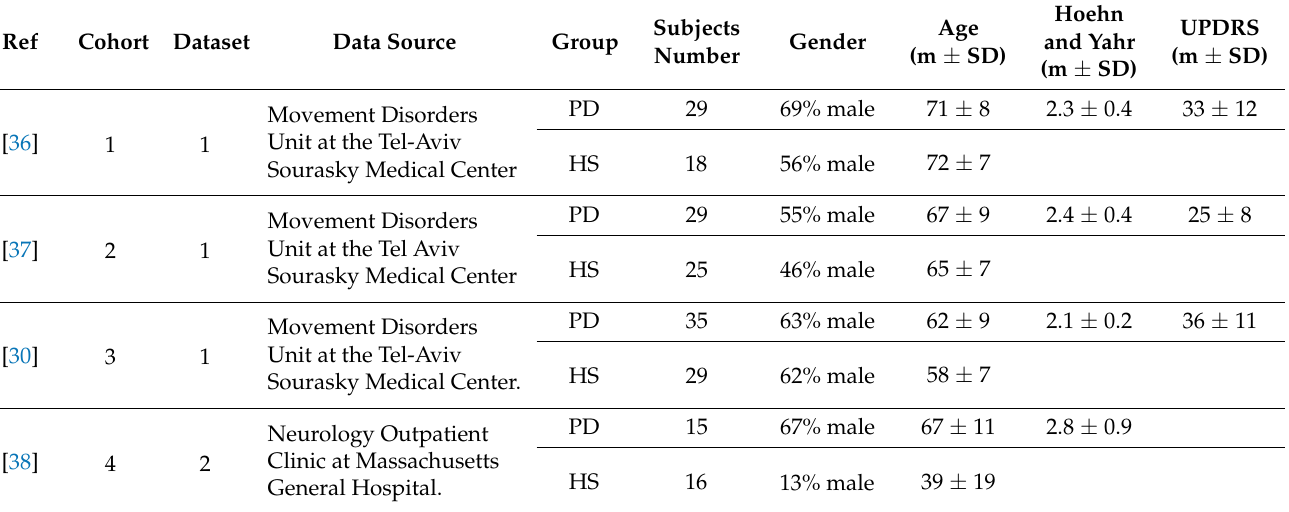
Table 1. Composition of